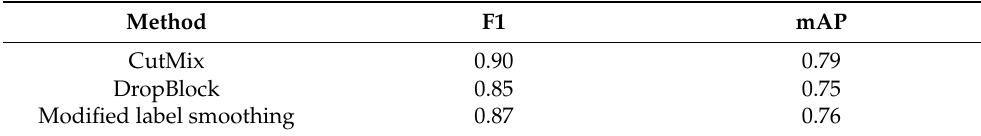
Table 6. Results of different data augmentation methods.